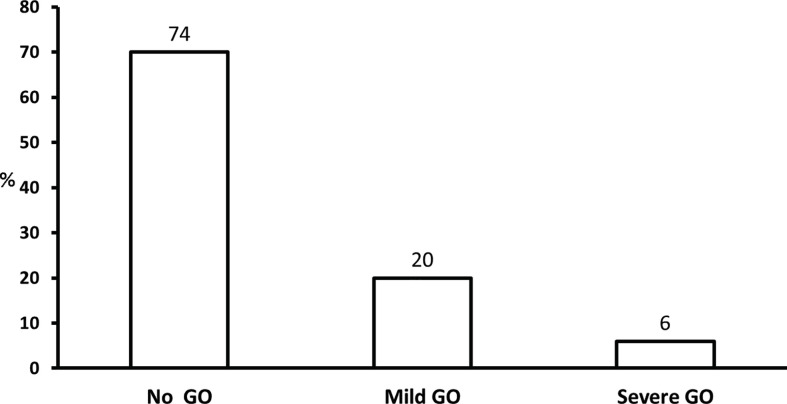
Prevalence and severity of Graves’ orbitopathy (GO) in 346 patients with recent onset and untreated Graves’ hyperthyroidism. Severe GO: moderate-to-severe and sight-threatening GO. Derived from Tanda et al. (13).